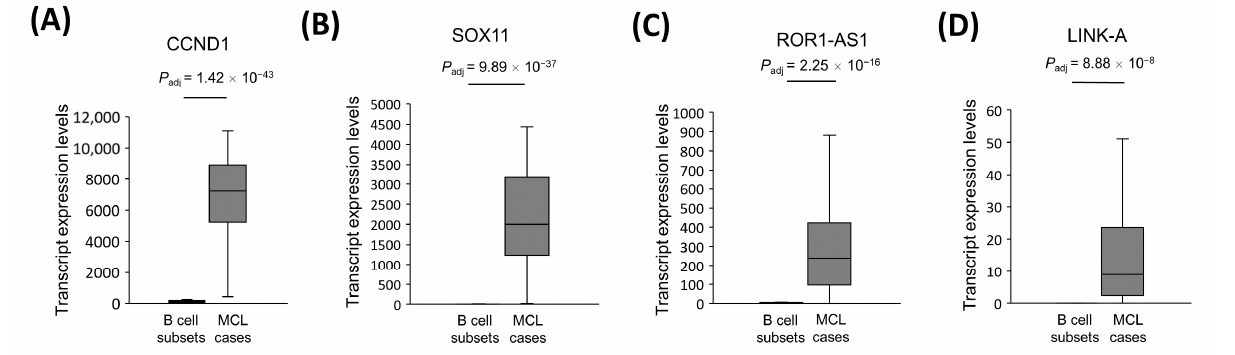
Figure 2. CCND1, SOX11, ROR1-AS1, and LINK-A transcripts are upregulated in MCL tumors. The transcript expression levels of CCND1 and SOX11 mRNAs as well as ROR1-AS1 and LINK-A lncRNAs in 32 MCL samples were compared with the 5 reactive tonsil B-cell subtype samples by DESeq2 analysis of whole transcriptome sequencing data. Box-and-whisker plots are shown for CCND1 ( A ), SOX11 ( B ), ROR1-AS1 ( C ), and LINK-A (LINC001139) ( D ) transcripts with the statistical significance indicated as adjusted p values over each